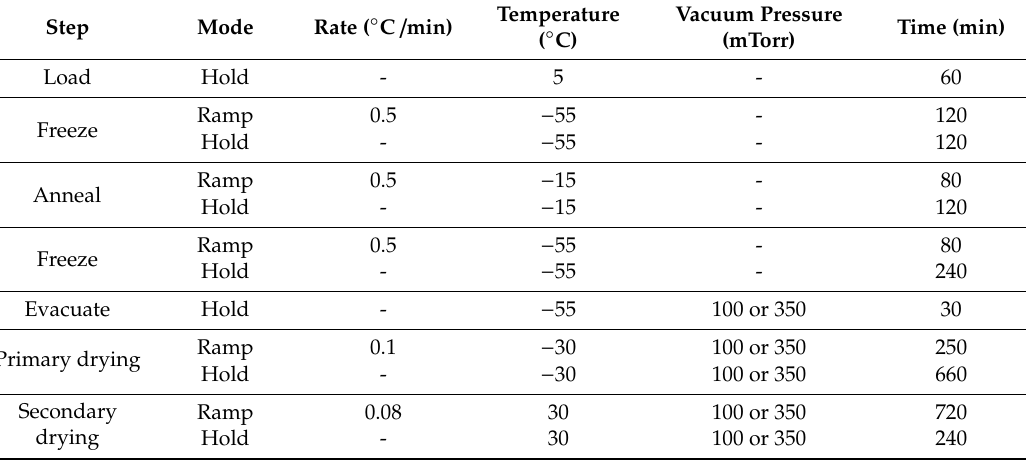
Table 2. Lyophilization parameters used in our study (Adapted from